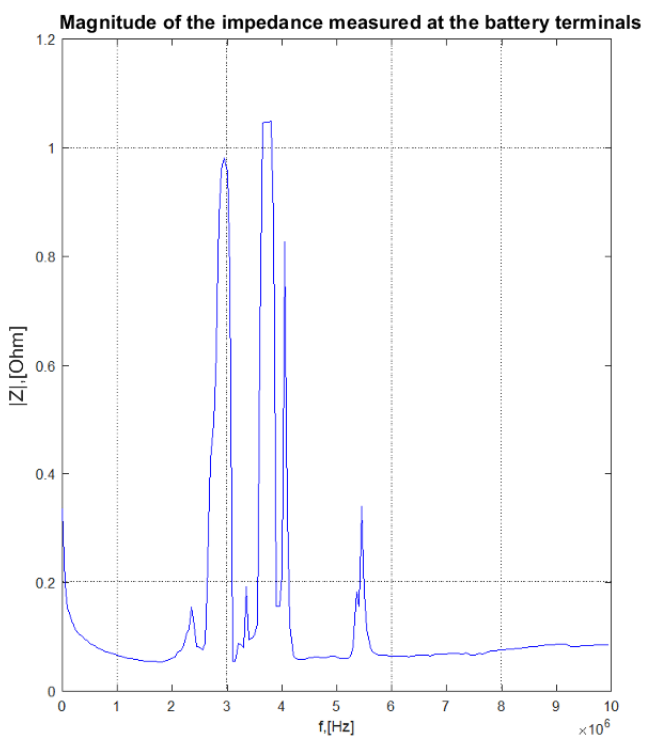
Figure 15. Linear characteristics of the impedance of the battery input pins as a function of fre- quency.